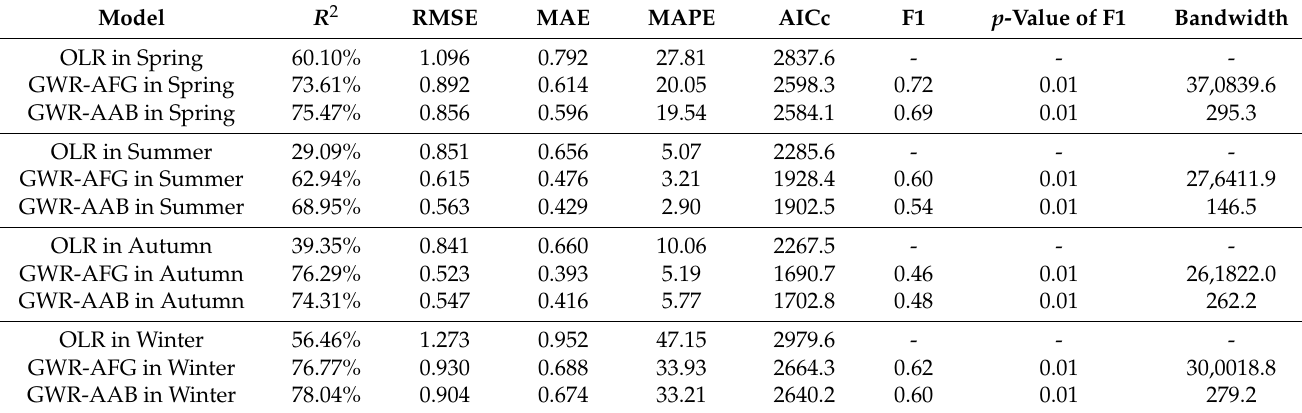
Table 5. Model performance of OLR and GWR for I-HFMD estimation in the four seasons.